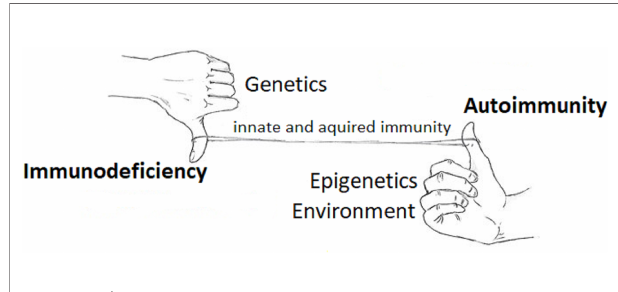
FIGURE 1 | An integrated view of the immune system in primary immunode fi ciency and autoimmune disorders. The fi gure illustrates the concept that immunode fi ciency (downregulation of the immune system - the hand with thumb down) and autoimmunity (upregulation of the immune system - the hand with thumb up) appear different categories of human pathology, the former more related to genetics, the latter to environment and epigenetics, while the interplay between these two apparently distinct categories is guaranteed by the common line of the innate and acquired immunity, which is dysregulated